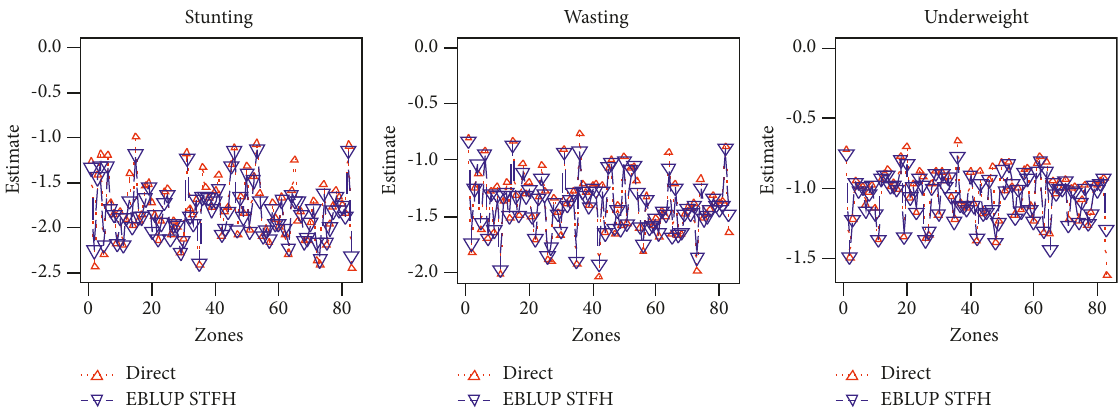
Figure 2: EBLUPs based on STFH model and direct estimates of children under five years of age for each zones.